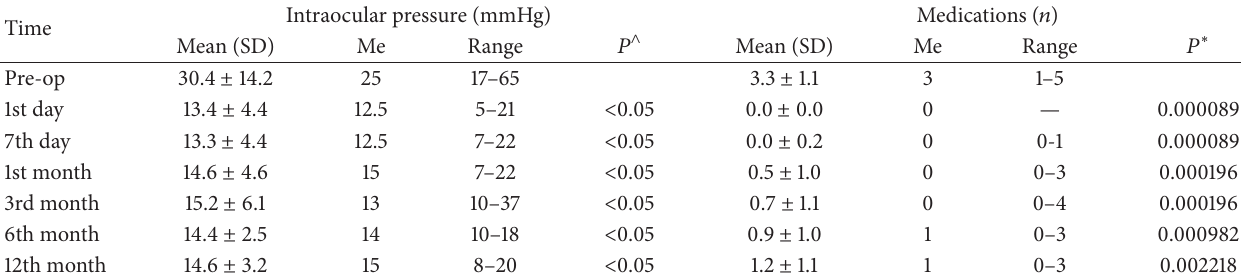
Table 2: Mean values, median number, standard deviations, ranges of intraocular pressure, and number of medications at specific times after surgery.